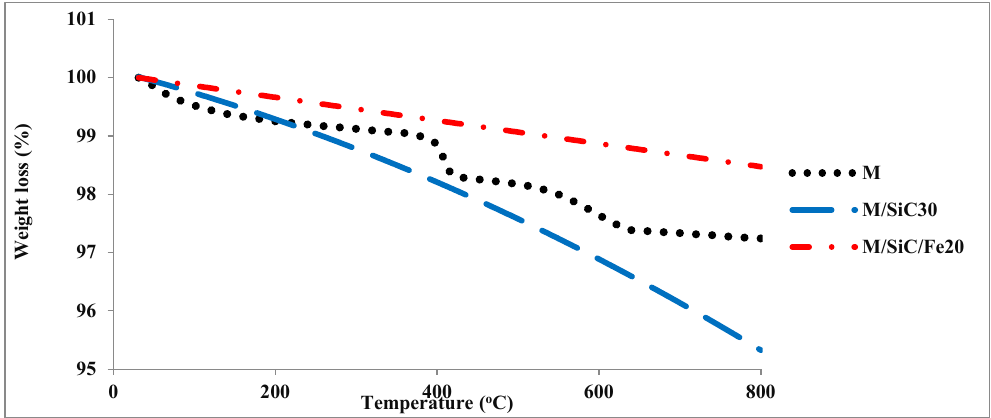
Figure 8. TGA of M, M/SiC30 and M/SiC/Fe20 microfiltration membranes.